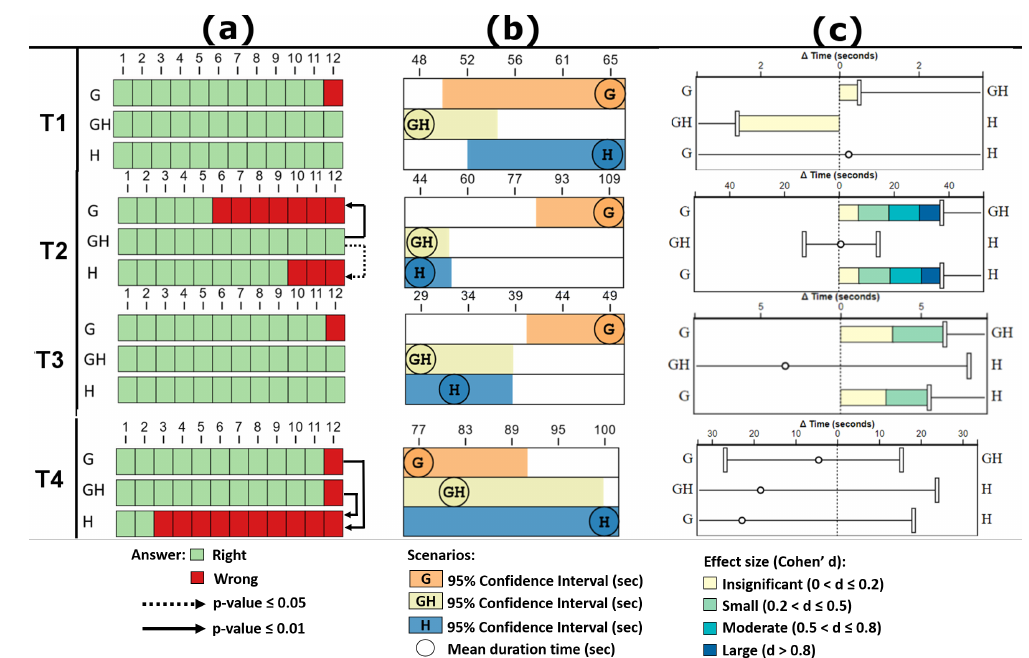
Figure 13. ( a )—Right/Wrong answers, and pair-wise test using bootstrapping; ( b )—Response time confidence interval; and ( c )—Pair-wise test time; for tasks T1, T2, T3, and